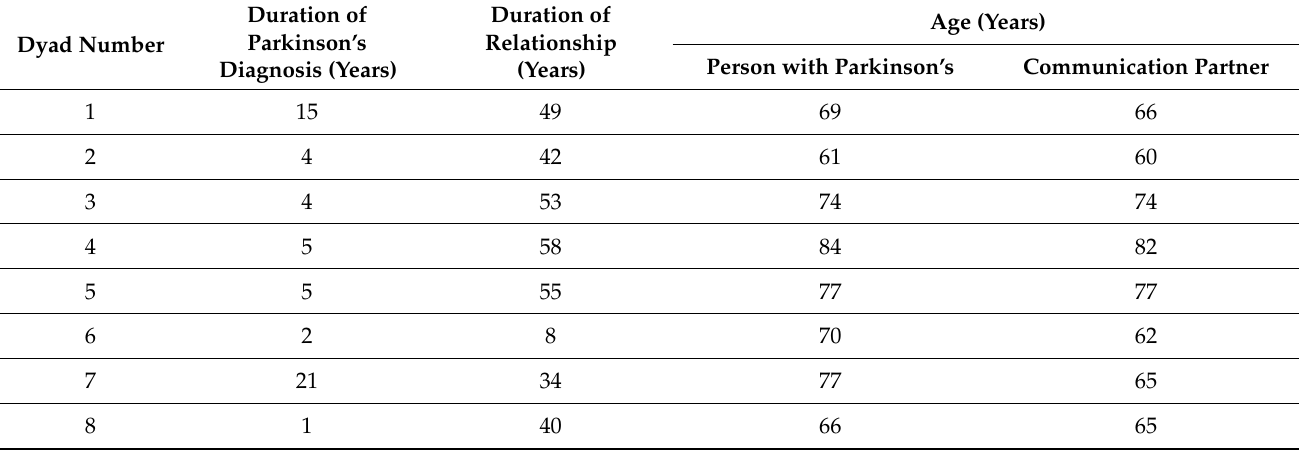
Table 1. Summary of participant demographic